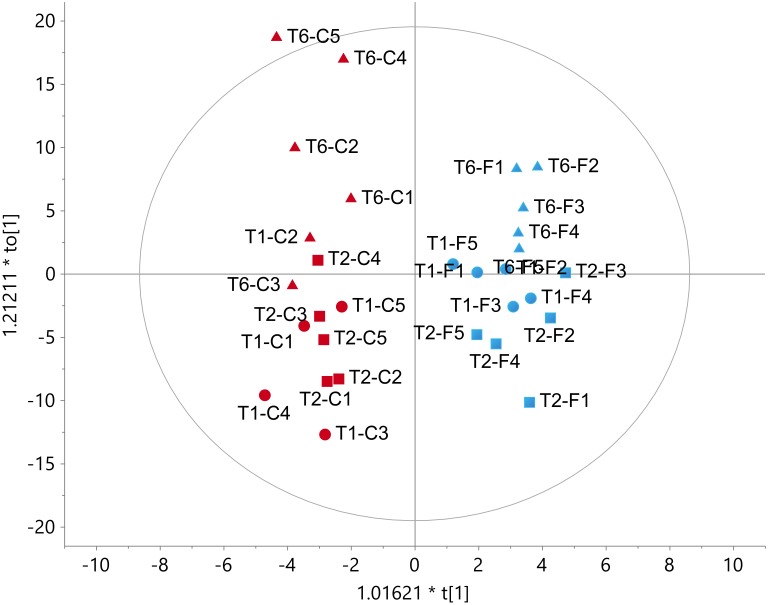
Score scatter plot for the OPLS-DA model on 1H-NMR spectra for D2O/ MeOH-d4 roots extracts of flooded (F, blue symbols) and control (C, red symbols) plants in five biological replicates (C1 to C5 and F1 to F5) at the three time points considered (R2Y = 0.93, Q2Y = 0.27). Solid cicles (): T1; Squares (): T2; Triangles (): T6.